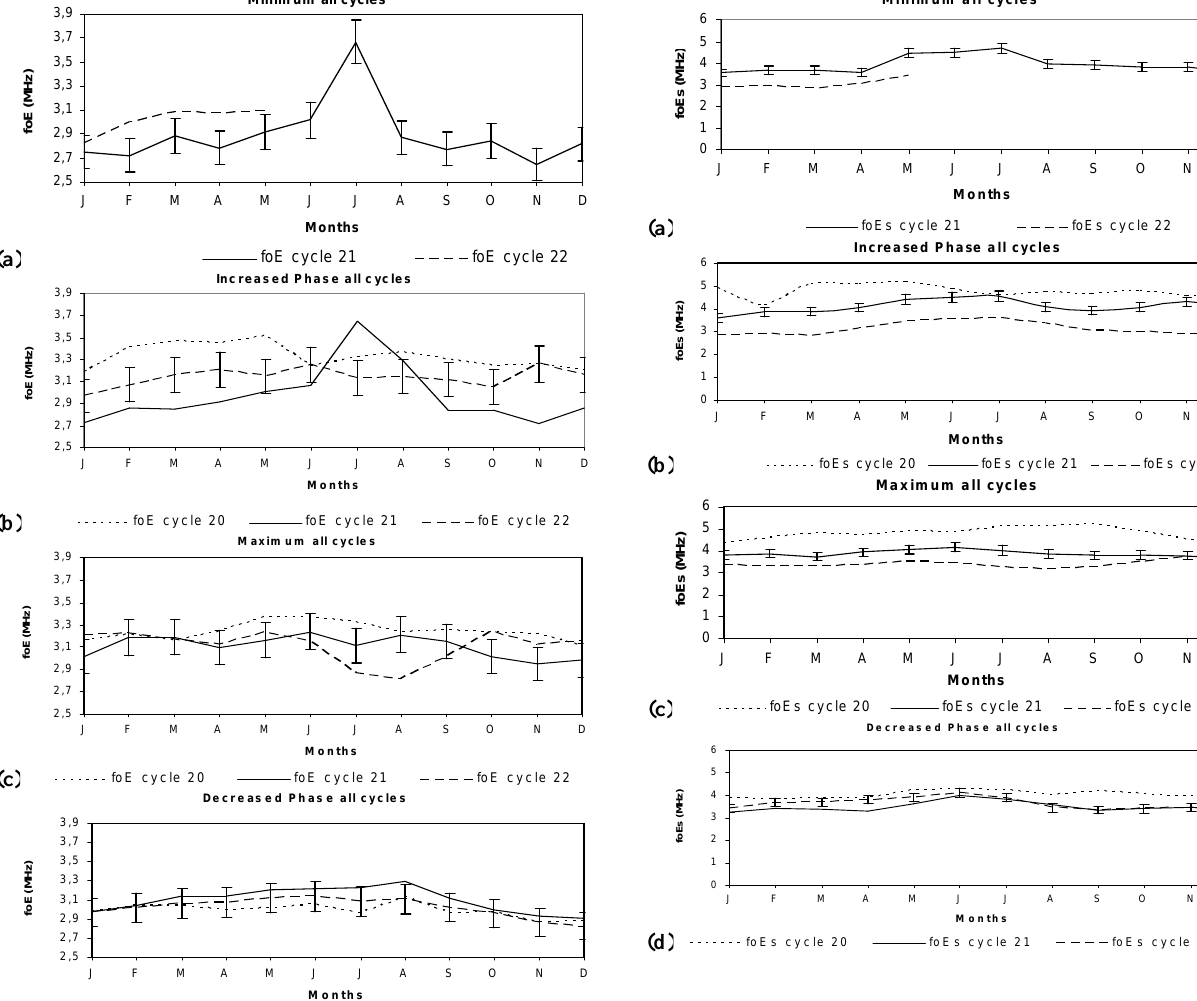
Figure 5 presents seasonal variation of fo Es during four solar phases. On this figure the seasonal graphs exhibit three maxima. By considering the error bars it can be seen that through the year from panel (a) (solar minimum phase) to panel (c) (solar maximum phase) seasonal ionization in Es layer decreases i.e. fo Es cycle 22 < fo Es cycle 21 < fo Es cycle 20 while in panel (d) all seasonal graphs show similar variation. Figure 6 presents the seasonal variation of h 0 F2 during four solar phases. All seasonal graphs show maximum virtual height in summer months and a trough at equinox months. Virtual heights increase as solar phases develop and as solar cycles increase. One can see dissymmetric min- ima during equinox months; in March equinox the trough is greater than October. Because the graphs present great differ- ence, it can be noted that h 0 F2 in Fig. 6b of cycles 21 and 22 appear to follow similar variations. The above h 0 F2 present a gap with h 0 F2 of cycle 20. This can be explained by the lack of data during the increasing phase of this